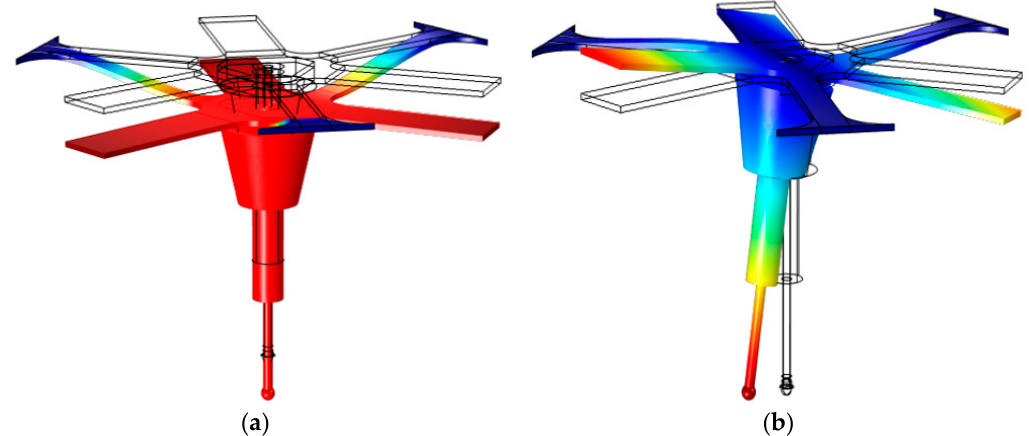
Figure 3. Shows mode shapes for zero applied compressive load: ( a ) the first mode (f = 1324 Hz), where the full micro-probe vibrates vertically; and ( b ) the second mode (f = 1700 Hz) where the centre of the micro-probe has a rotational motion.